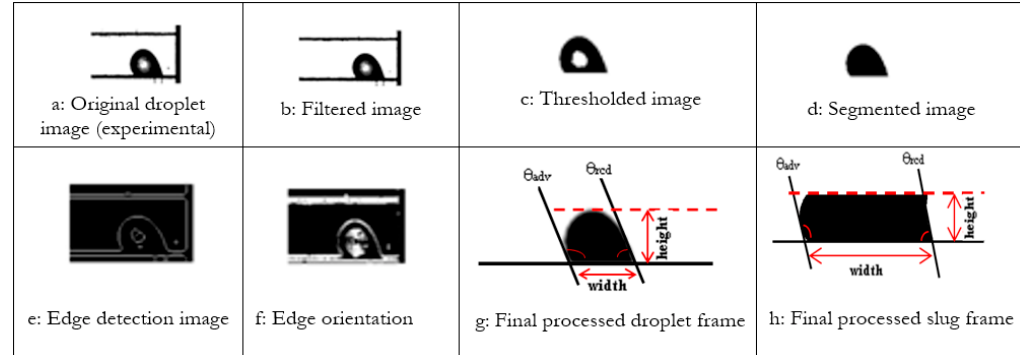
Figure 3. Sequence showing digital capture and detection of dynamic water droplet and slug movement within the channel to extract desired flow parameters.